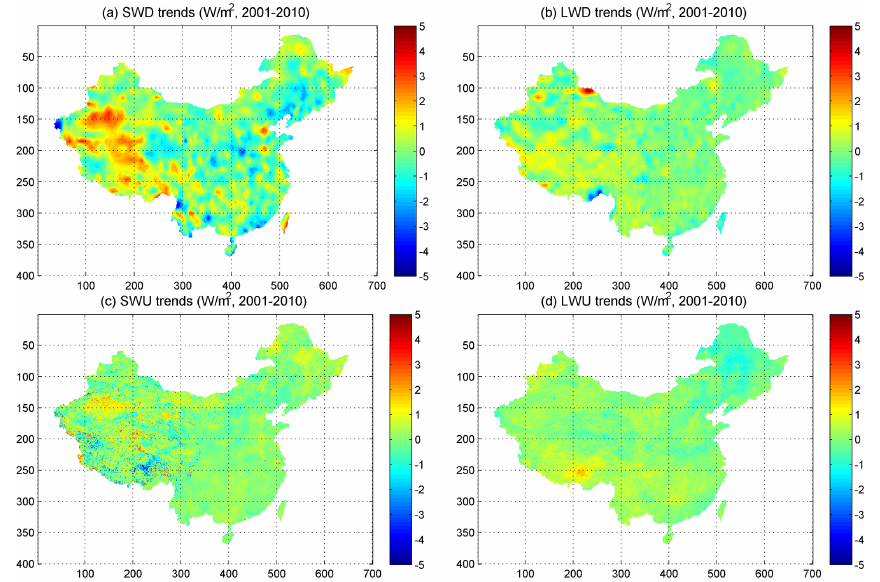
Figure 12. Spatial trends of (a) SWD (downward short-wave), (b) LWD (downward long-wave), (c) SWU (upward short-wave), and (d) LWU (upward long-wave) radiation for the Chinese landmass from 2001 to